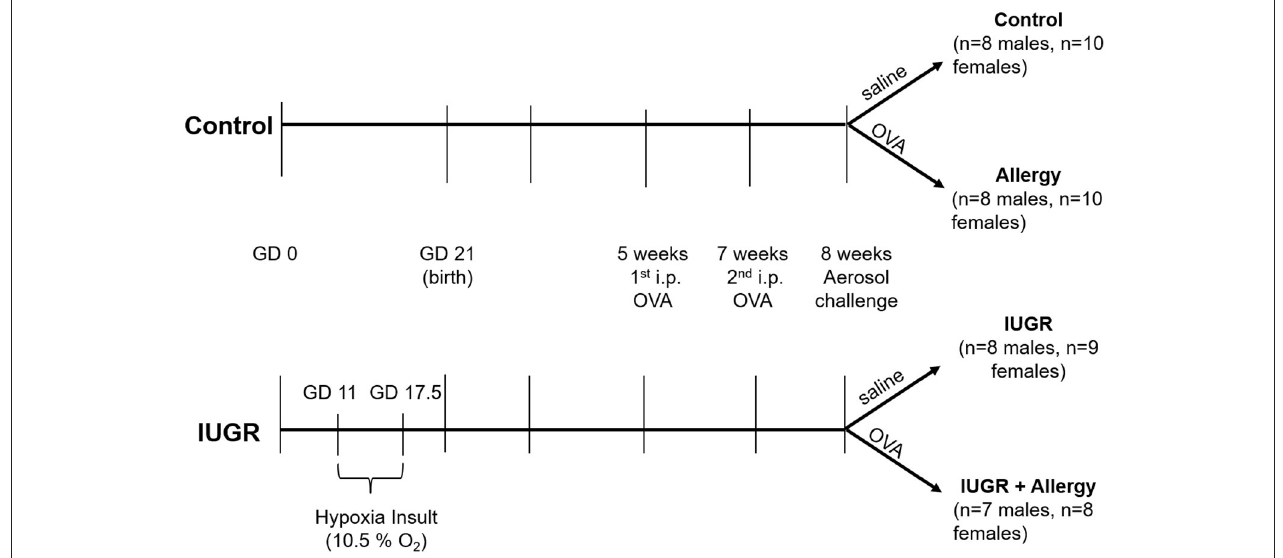
FIGURE 1 | Protocol for IUGR and allergy induction in mice. The superimposition of a maternal hypoxia-induced IUGR model and a well-established allergen protocol, produced 4 experimental groups; Control, Allergy, IUGR and IUGR